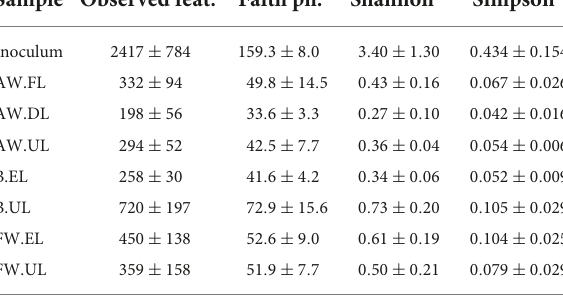
TABLE 1 Alpha diversity indexes for quantification of the biodiversity degree within the vinegar samples. Sample Observed feat. Faith